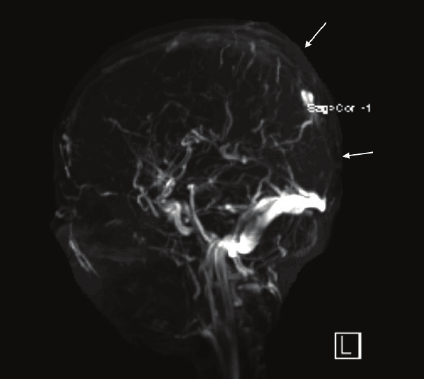
Figure 2: Axial T2-weighted MRI shows bilateral acute venous infarctions with hemorrhage (arrow) involving right frontal lobe.